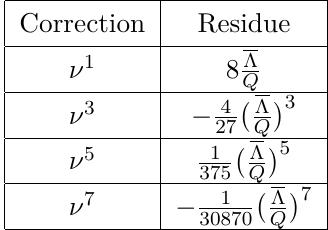
Table 1 . The size of the residues of renormalon singularities for soft power corrections. The numbers quoted are π times the residue and Λ = Λ e 5 / 6 . We ignore here the O (1) factor C F / 2 β 0 in eq.